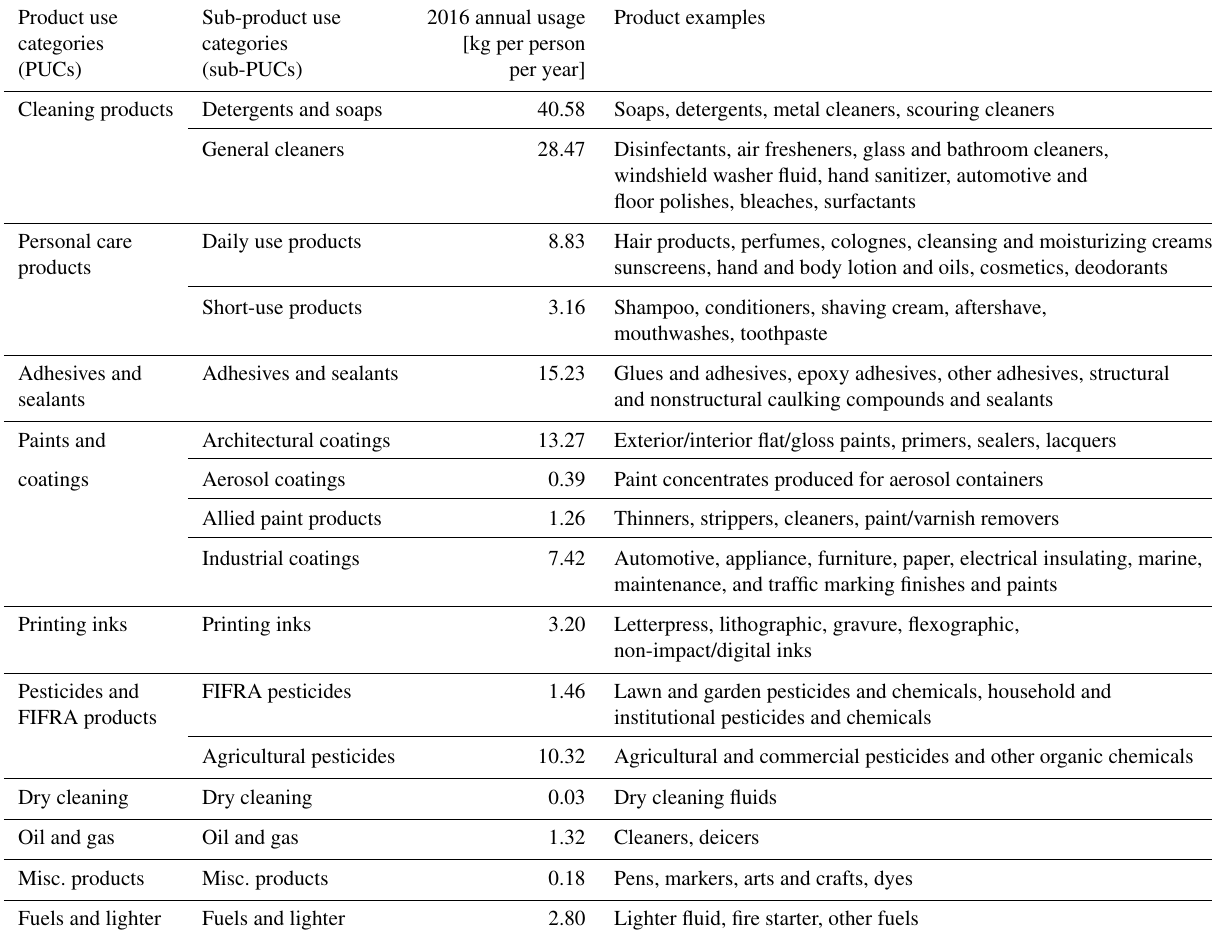
Table 1. Description of all PUCs and sub-PUCs currently implemented in VCPy, their estimated mass usage for 2016, and product examples of each. See Table S2 for a derivation of all product usage